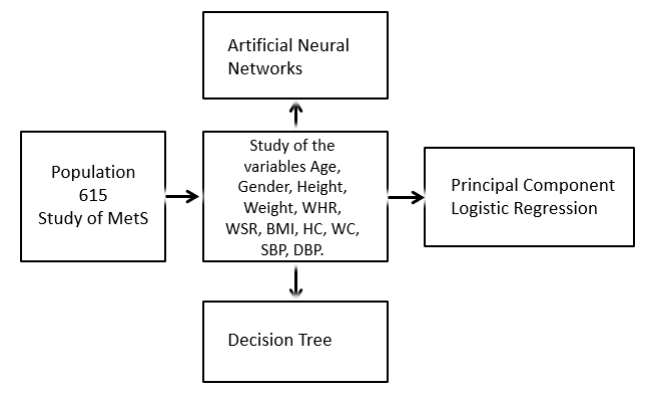
Figure 4. Process of analysis of the classification